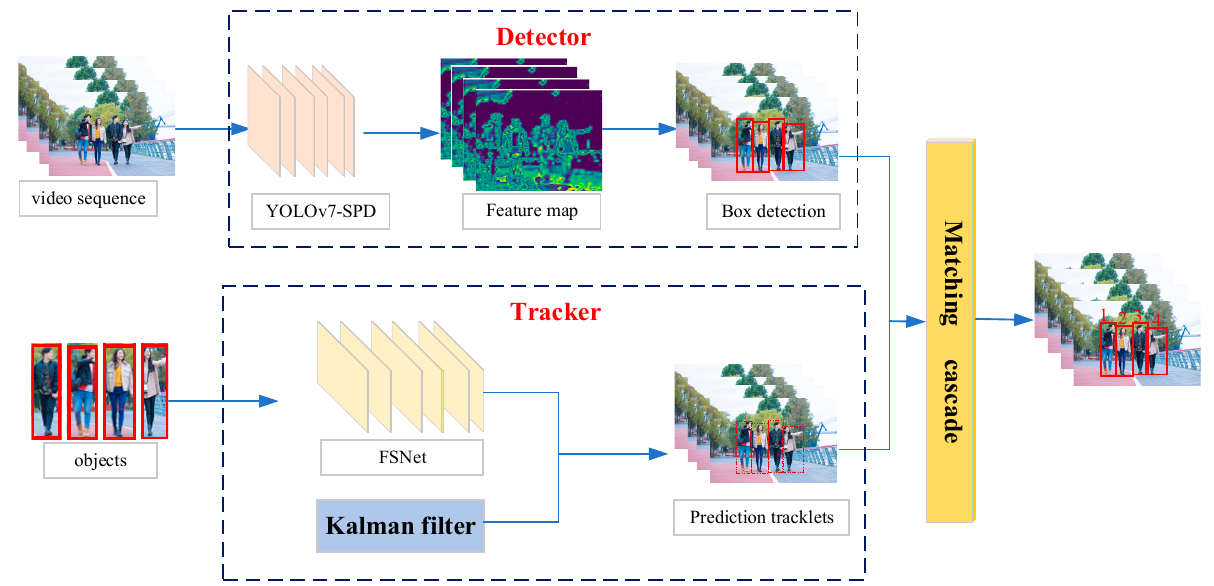
Figure 2. Structure of the detector–tracker integration